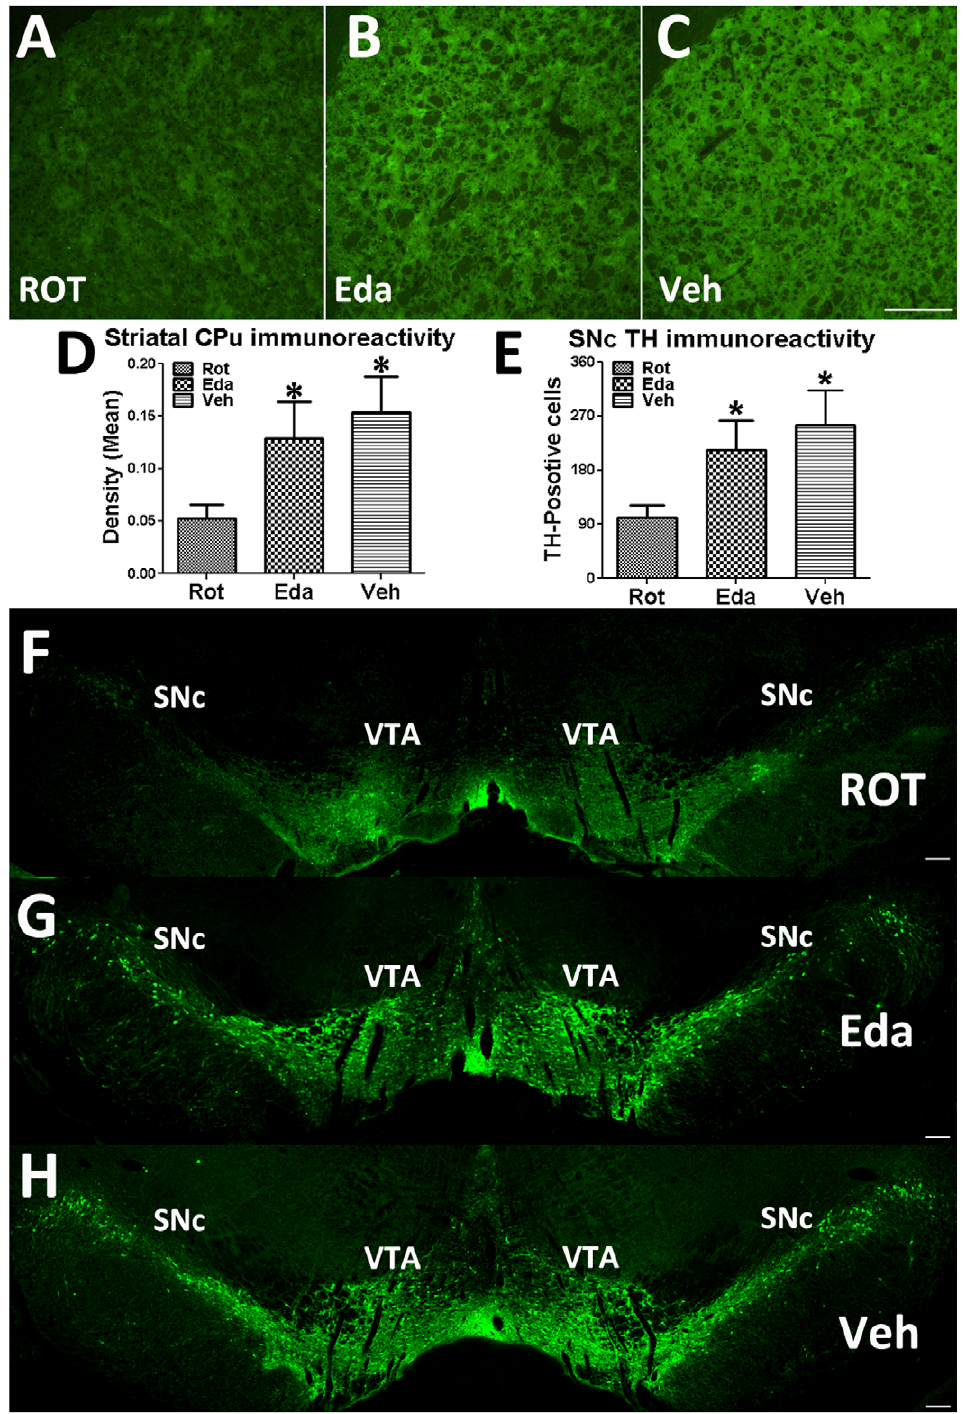
Figure 3. TH immunoreactivity in CPu and SNc. (A), (B) and (C), TH immunoreactivity in the CPu of Rot-group, Eda-group and Veh-group, respectively; (F), (G) and (H), TH-positive neurons in the SNc of Rot-group, Eda-group and Veh-group; (D) and (E), Quantitation of TH immunoreactivity in CPu and TH-positive cells in SNc (* P , 0.05 compared to ROT-group; scale bars =100 m m). doi:10.1371/journal.pone.0020677.g003 neurons of the edaravone rats was up-regulated by 69.94% difference between Eda-group and Veh-group, suggesting that compared to the Vehicle-treated rats (Fig. 6B–J). SNCA mRNA NBP up-regulated the expression of the DA neurons-protective levels (Fig. 6A), SNCA protein expression (Fig. 6K–S) and TH- protein VMAT2 without inducing SNCA over-expression (which positive cell numbers (Fig. 6L,P,T) in the SNc displayed no has been proven to be harmful to DA neurons).